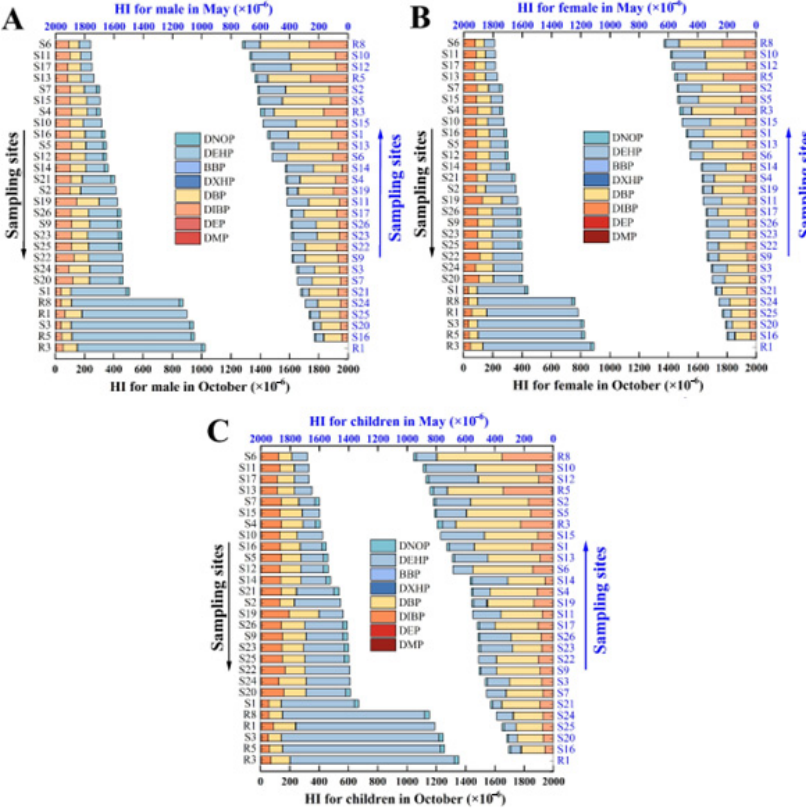
Figure 4. Results of human health risk assessment via drinking water and skin contact for males ( A ), females ( B ) and children ( C ) in October and May.